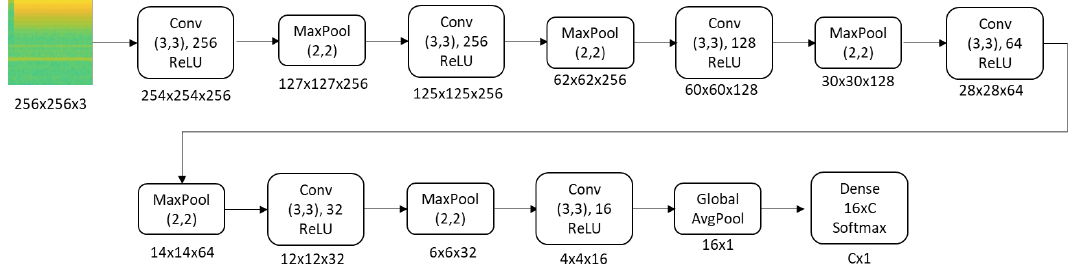
Figure 9. Convolutional Neural Network (CNN)